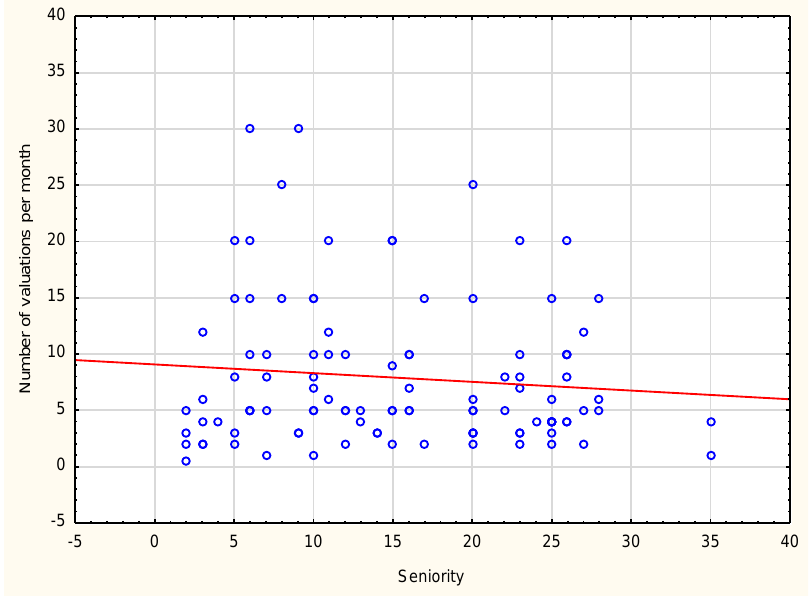
Figure 1. Correlation between seniority and the number of valuations produced.